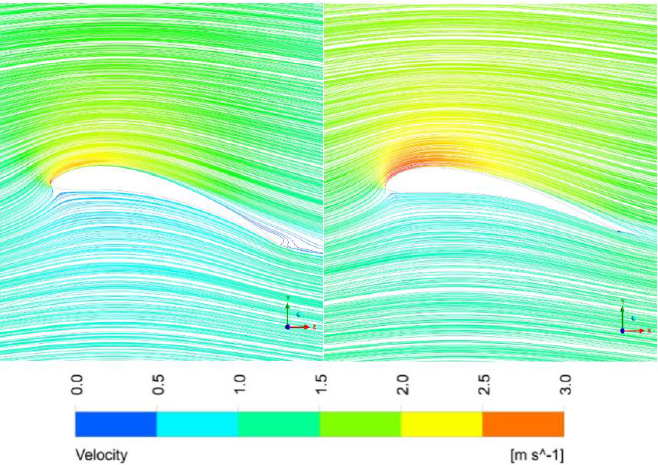
Figure 13. Streamline diagram of the optimized airfoil velocity of the seagull airfoil at an angle of attack of 10°. (Initial airfoil on the left, optimised airfoil on the right).